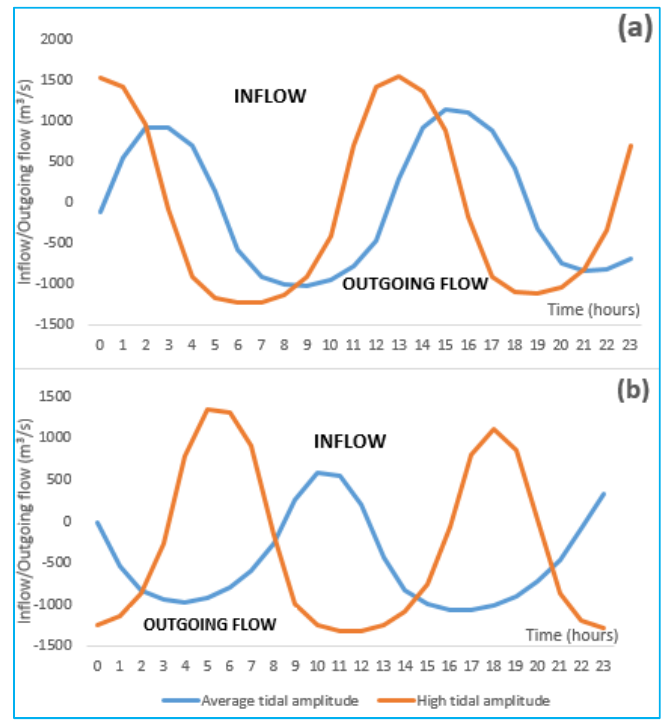
Figure 9. Diurnal cycle of flow during low water period ( a ); and flood period ( b ).